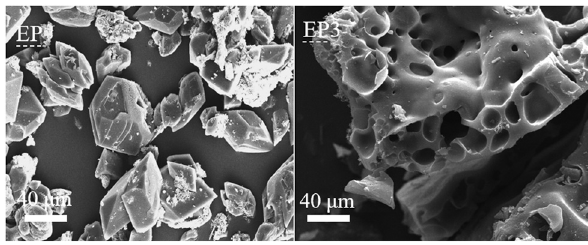
Figure 12: SEM images of EP and EP3 char